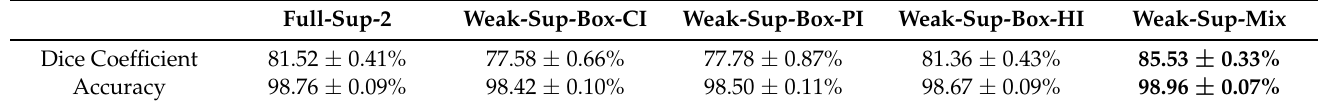
Table 2. Average test-set scores and standard deviation using 10-fold cross-validation on the Polyp- Box-Seg images. The neural networks in this table are pre-trained on the public CVC-ClinicDB dataset and then further trained as described in the